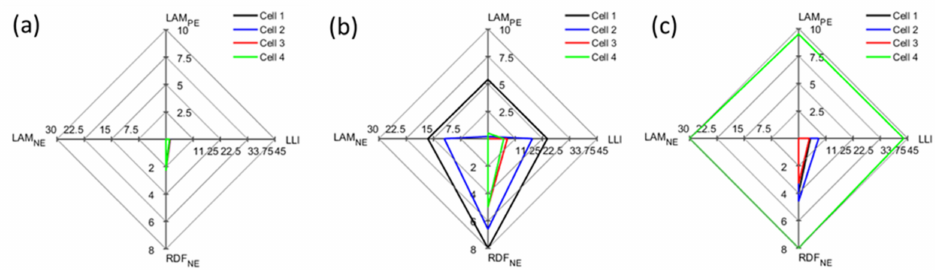
Figure 13. Radar plots showing the different degradation mechanisms for Cells 1 to 4 in ( a ) the 4S pack at 25 ◦ C; ( b ) the 4S pack at 0 ◦ C with cell cutoff and ( c ) the 4S pack at 0 ◦ C with pack cutoff.